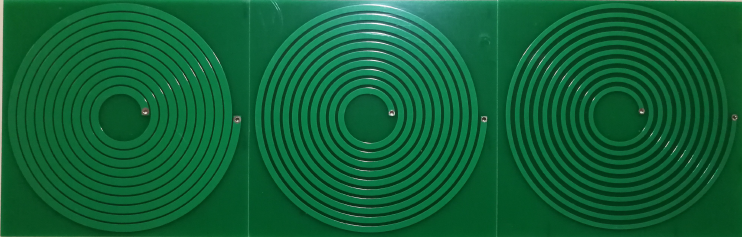
Figure 20. Group-3 prototypes with track width 5 mm ( left ), 4 mm ( middle ) and 3 mm ( right ).